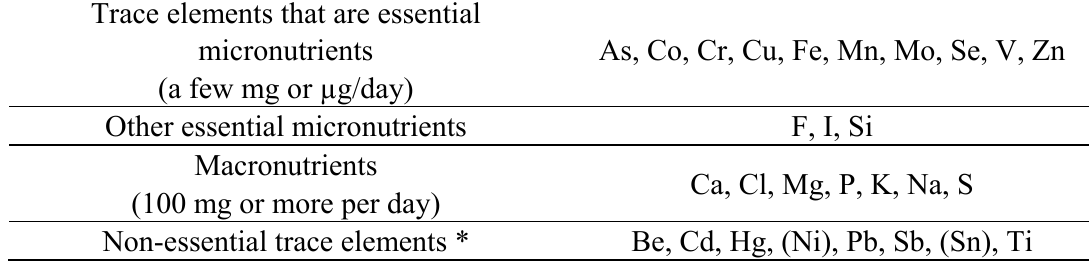
Table 1. Micronutrients and macronutrients for optimum working of live organisms (collected from different sources by Siegel [2]).